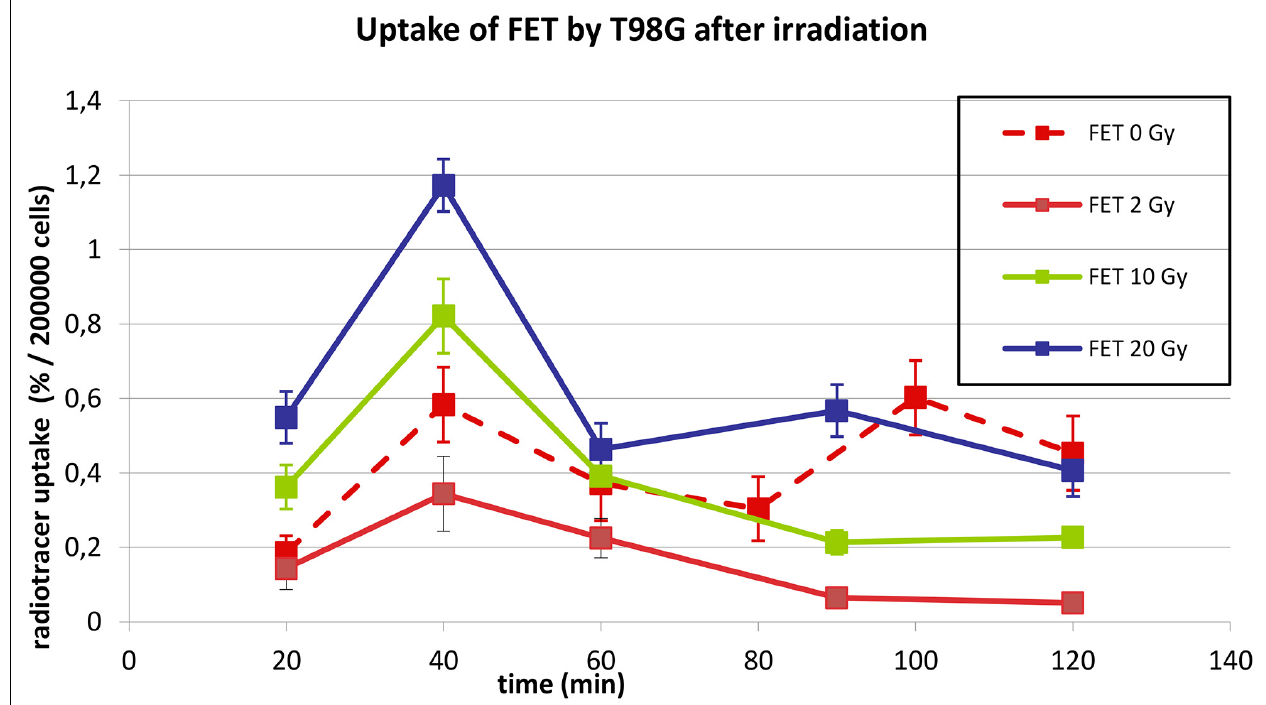
FIGURE 2 | Uptake of 18 F-FET in T98G cells in basal condition and after photon irradiation with 2, 10, and 20 Gy.